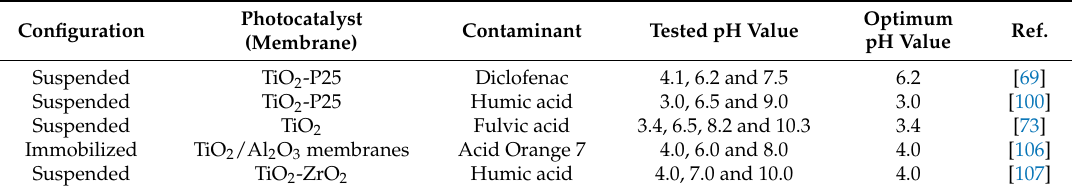
Table 4. Optimal pH values attained in different PMR